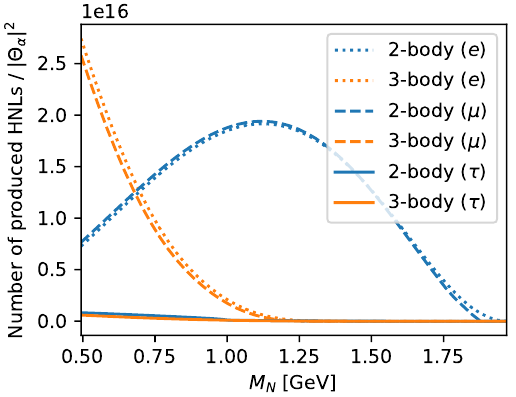
Figure 4. Number of HNLs produced at SHiP as a function of the primary decay multiplicity, for a coupling to one